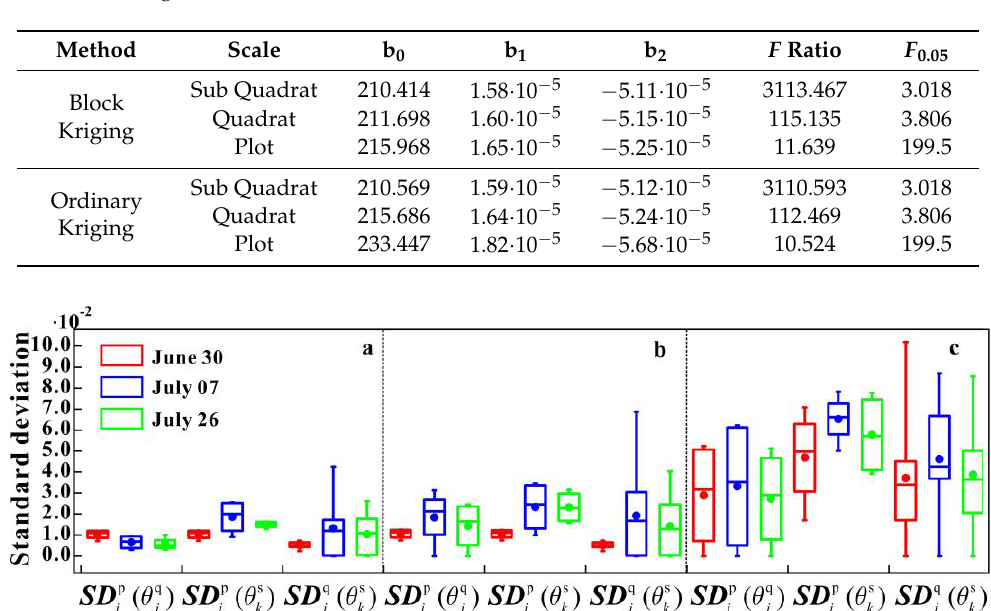
Figure 11. Box plots of standard deviations (m 3 ·m −3 ) based on upscaled estimations by block kriging ( a ), ordinary kriging ( b ), and simple averaging ( c ) of the smaller scale pixel within each larger scale pixel on June 30, July 7, and July 26.